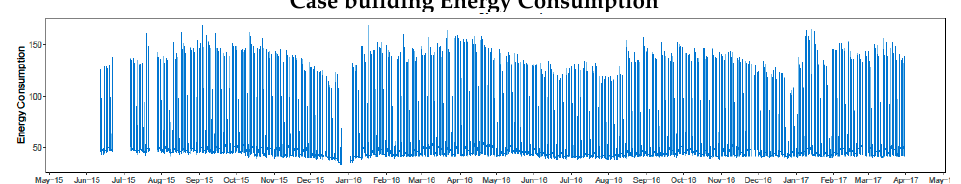
Figure 1. Electricity consumption and cooling thermal energy consumption data from June 2015 to March 2017.